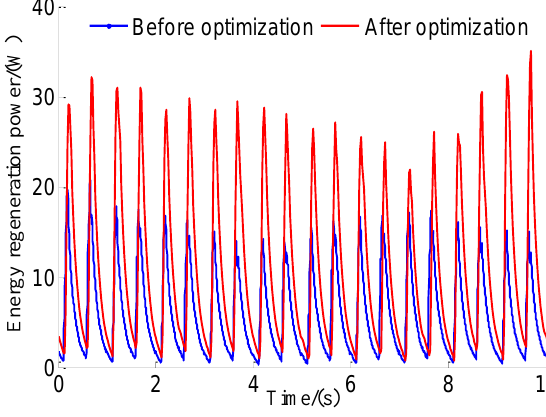
Figure 14. Test chart of energy regenerative power response.